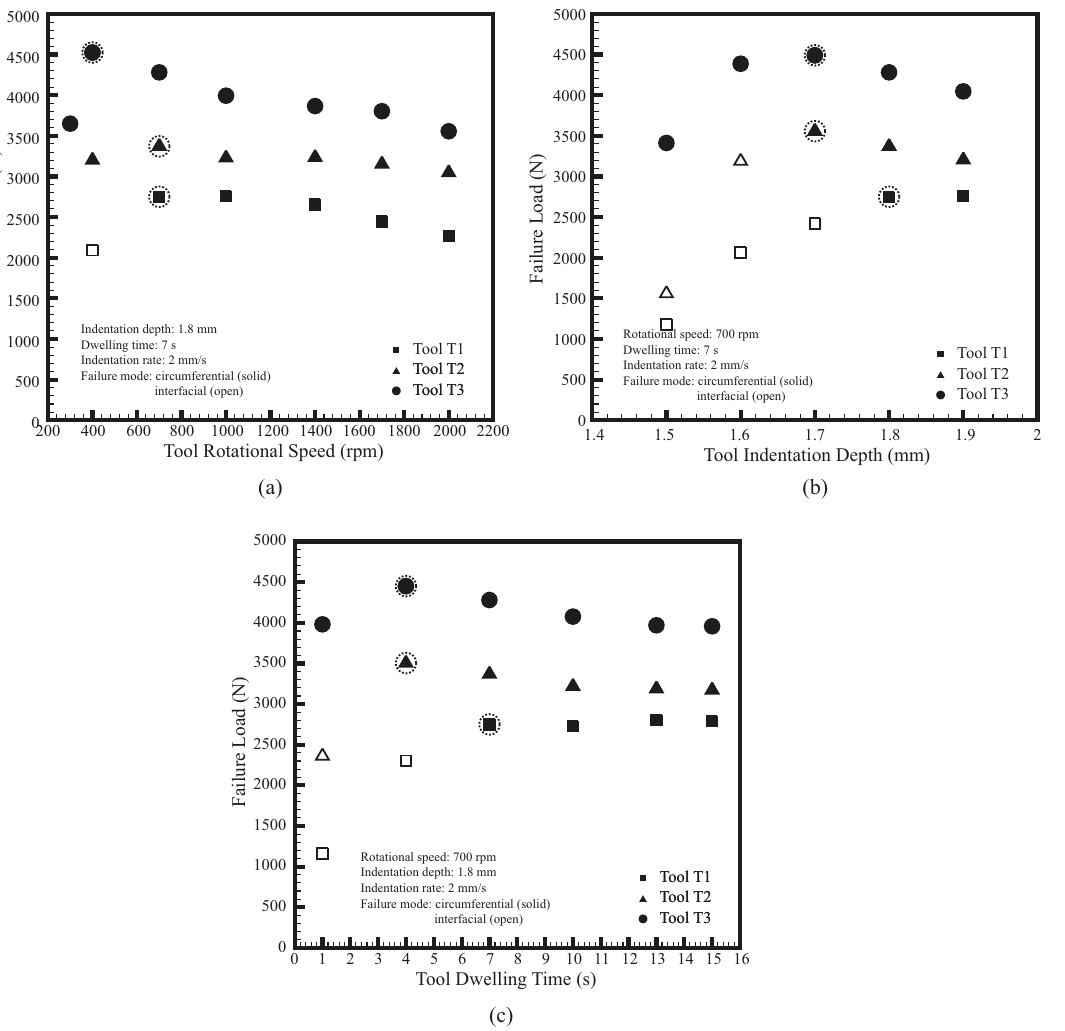
Figure 8. Average failure loads as functions of ( a ) rotational speed; ( b ) indentation depth; and ( c ) dwelling time for FSSWs made by the three weld tools under lap-shear loading conditions.